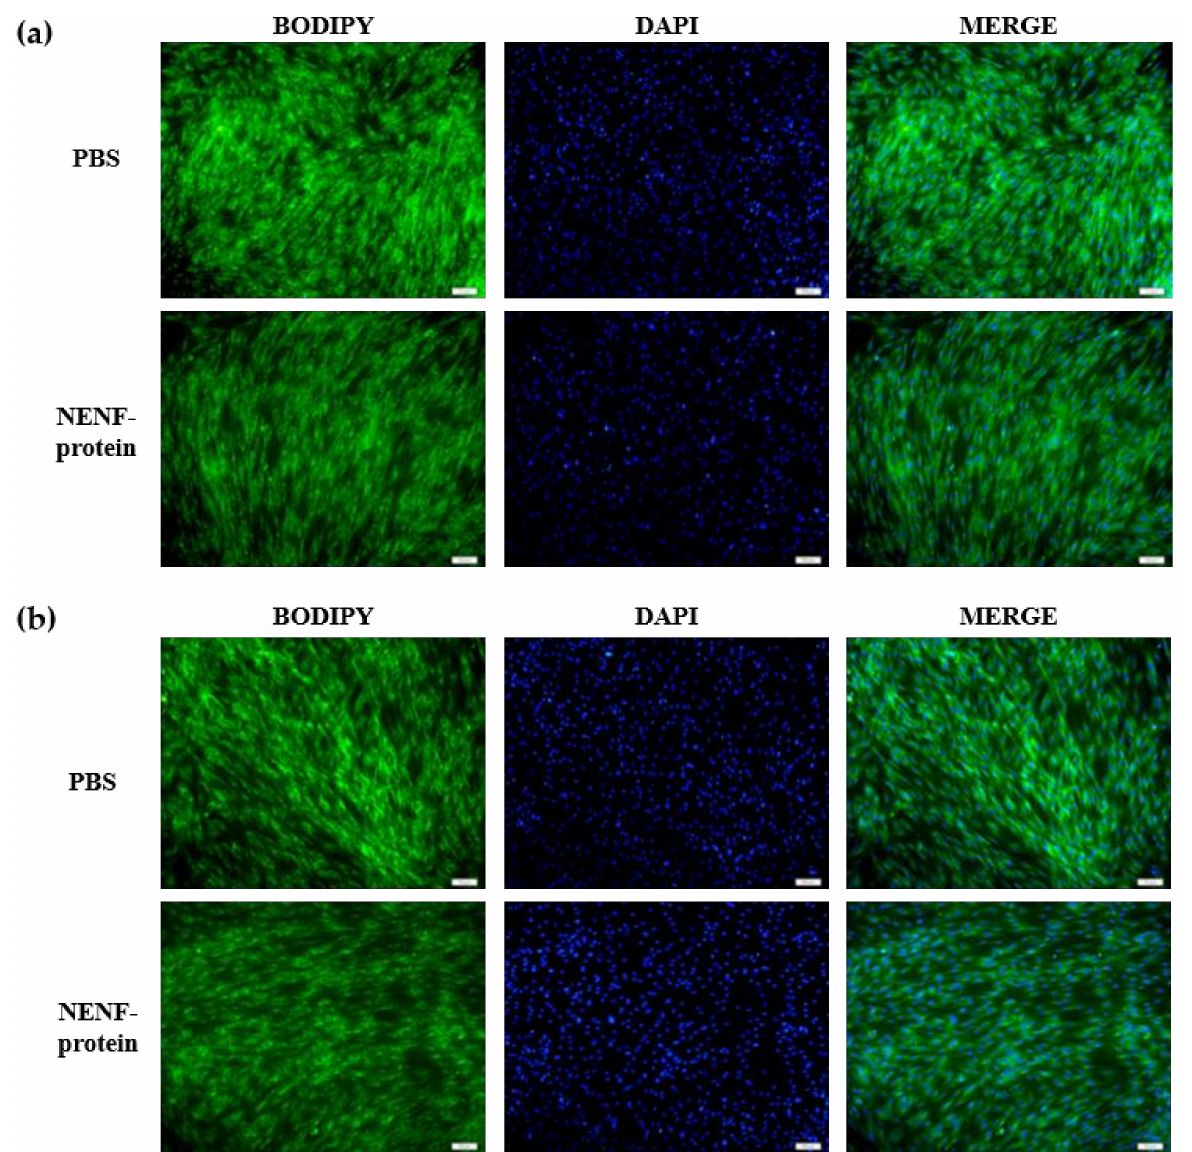
Figure 3. Effects of adding NENF recombinant protein on preadipocyte differentiation in co-culture system. ( a ) Bovine adipocytes are stained with BODIPY (green) and DAPI (blue) after adding the recombinant protein NENF and PBS at 4th day of natural differentiation (D4); ( b ) 6th day of natural differentiation (D6). (OLYMPUS IX71 100 ×